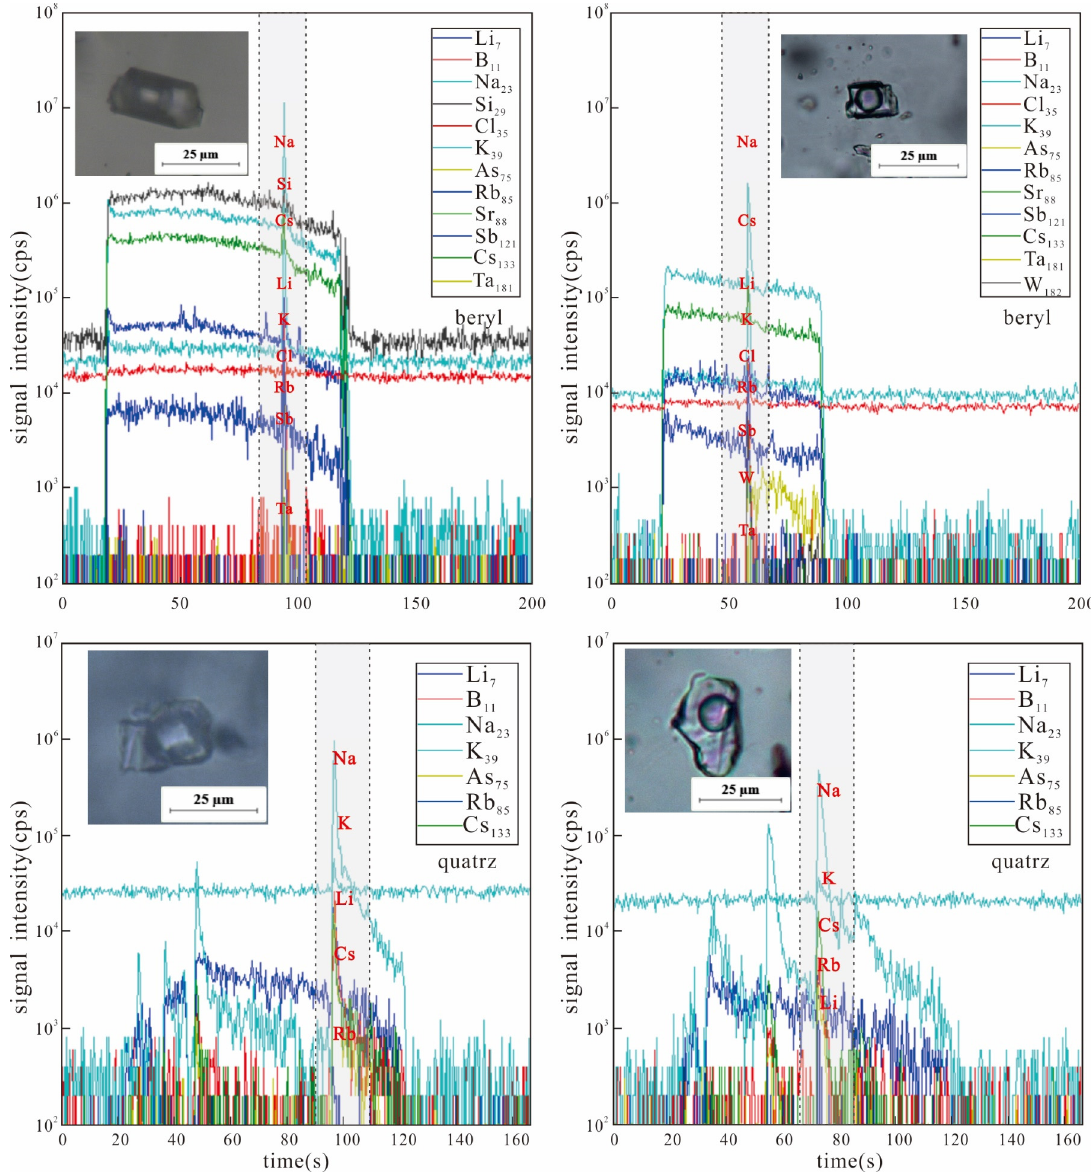
Figure 10. LA-ICP-MS time resolution profiles of single fluid inclusions in various minerals of Dakalasu No. 1 pegmatite vein.